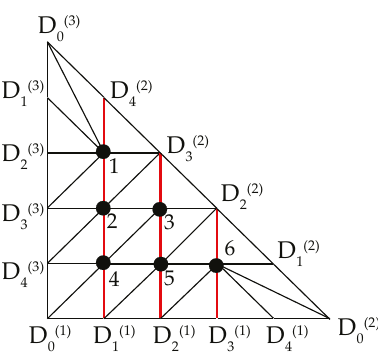
Figure 17 . The ruling structure of compact surfaces in the example of T 5 theory. Each red vertical line denotes the section curve of the ruling. The quiver gauge theory description is [5] (cid:0) SU(4) 0 (cid:0) SU(3) 0 (cid:0) SU(2) (cid:0)